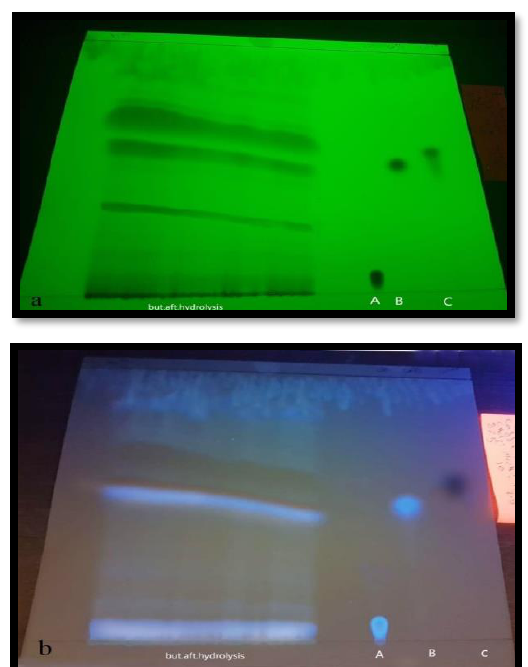
Figure .2. Preparative TLC chromatogram of n-butanol hydrolyzed fraction at a: 254 and b:365, A : caffeic acid B: luteolin C : resorcinol , mobile phase CHCl3 :MeOH ( 90 :10)